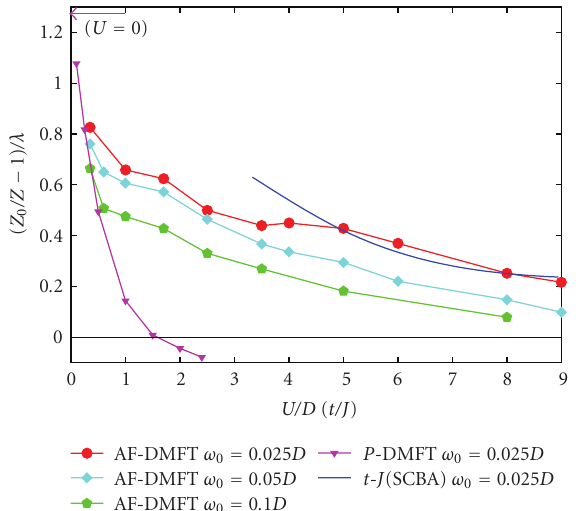
Figure 10: E ff ect of the Coulomb repulsion on the linear con- tribution in λ to the quasiparticle renormalization. DMFT results for the antiferromagnetic phase (AF-DMFT) are compared with DMFT in the paramagnetic state (P-DMFT) and to a self-consistent Born Approximation (SCBA) for the t-J model for parameters corresponding to the red dots AF-DMFT. Antiferromagnetism allows for a sizable e-ph coupling also in the present of very strong Coulomb repulsion, in contrast with paramagnetic results (after Sangiovanni et al. [92]).